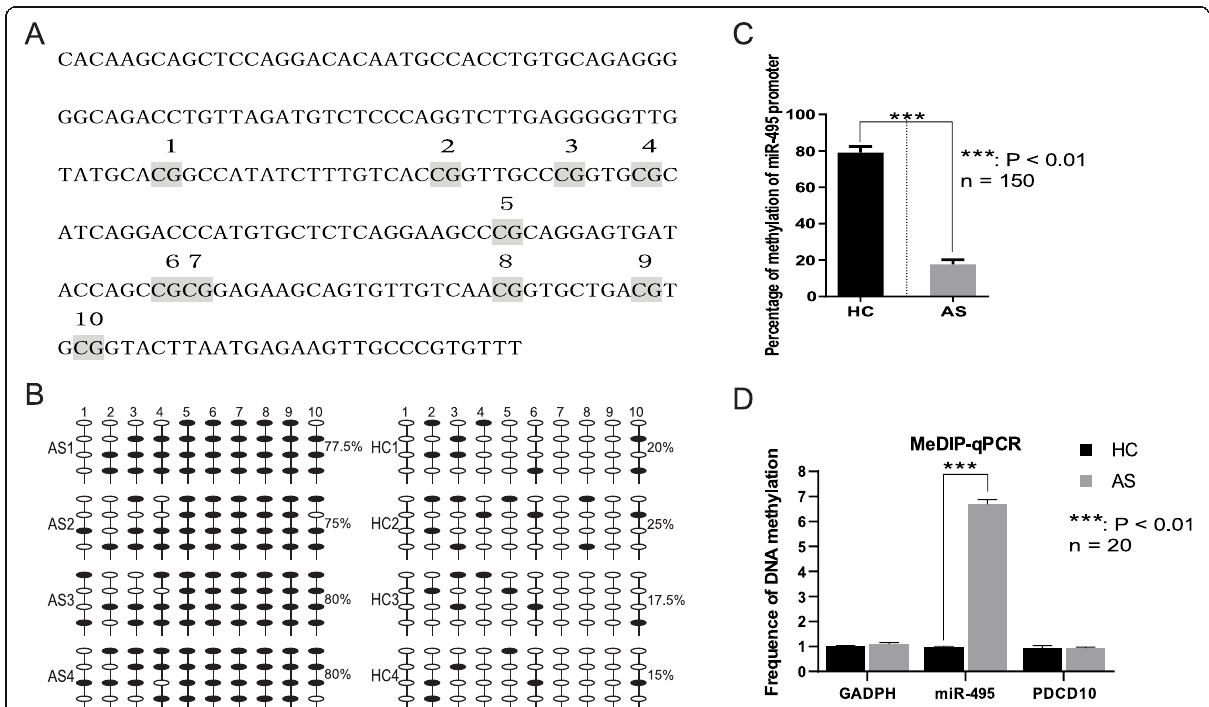
Fig. 2 Methylation detection of miR-495 promoter region. All data was presented as the mean + SD. a Sequence schema of the bisulfite-specific PCR sequenced region in the miR-495 promoter region. Numbers (1 – 10) indicate potential CpG islands. b Methylation status of CpGs in the miR- 495 promoter region. White and black circles indicated un-methylated and methylated CpGs, respectively. AS1, AS2, AS3, AS4: different patients with AS. HC1, HC2, HC3, HC4: different healthy controls. c The percentage of miR-495 promoter methylation. The percentage of miR-495 promoter methylation in healthy controls and patients with AS was 0.79 + 3.30 and 0.18 + 2.63, respectively. d MeDIP-qPCR of GADPH , miR-495 , and PDCD10 promoters. The values of GADPH promoter methylation in healthy controls and patients with AS were 1.01 + 0.025 and 1.10 + 0.064, respectively. The values of miR-495 promoter methylation in healthy controls and patients with AS were 0.97 + 0.036 and 6.68 + 0.224, respectively. The values of PDCD10 promoter methylation in healthy controls and patients with AS were 0.93 + 0.11, and 0.94 + 0.028, respectively. n = 150 or 20: tested samples in each group. AS: patients with ankylosing spondylitis. HC: healthy controls. ***: P value <